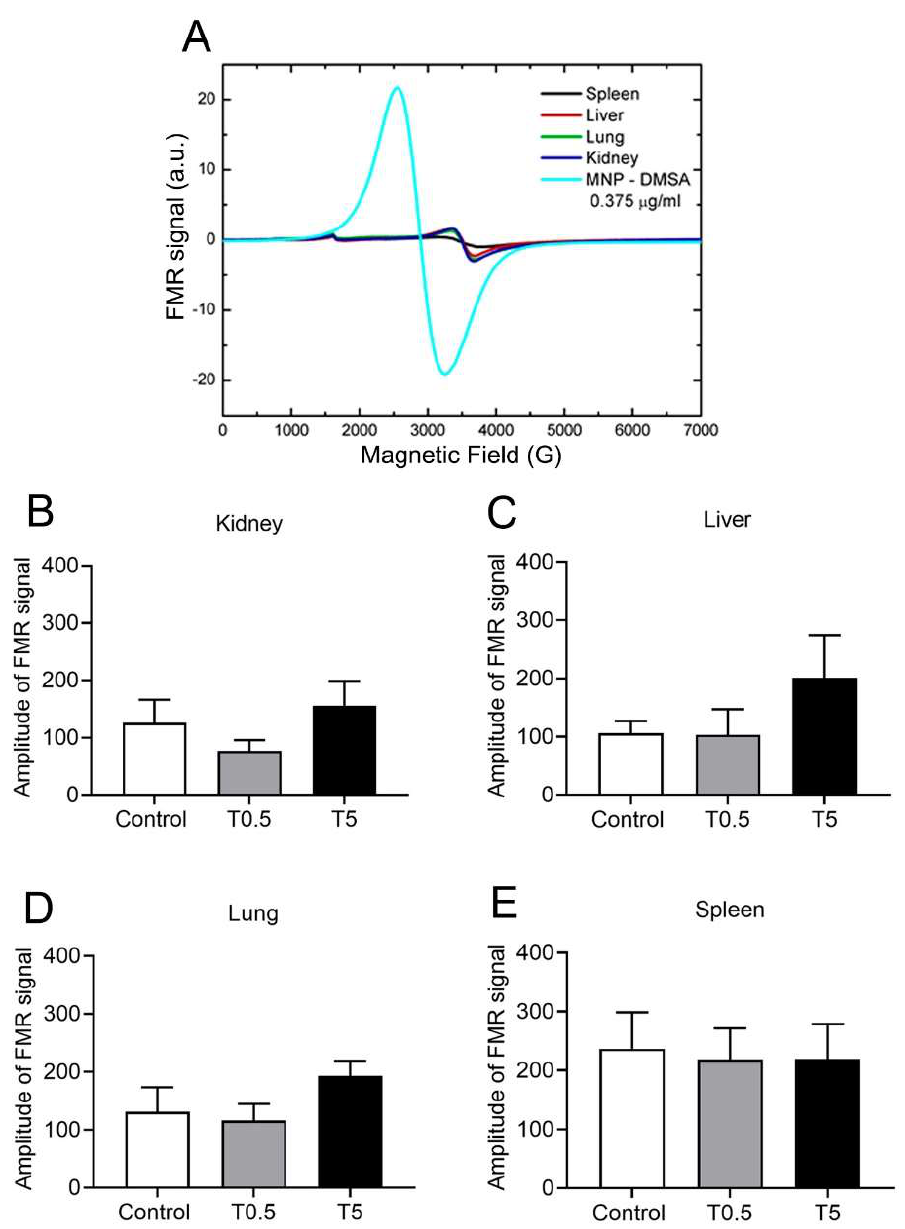
Figure 6. ( A ) Comparison of spectra of biological samples with pure DMSA-MNP spectrum. The tissue samples spectra presented the characteristic signal of Fe 3+ high spin at 1500 G (g ≈ 4.3) was due to glass capillary contamination and another transition around 3500 G (g = 2.00) was due to endogenous iron oxide. The DMSA-MNP and tissue sample spectra are unmistakably different. ( B – E ) Peak-to-peak transition amplitude around 3500 G (g = 2.0) from kidney, liver, lung, and spleen samples in control and treatment conditions (groups T0.5 and T5). Data are expressed as mean ± SEM for 5 animals in each group.